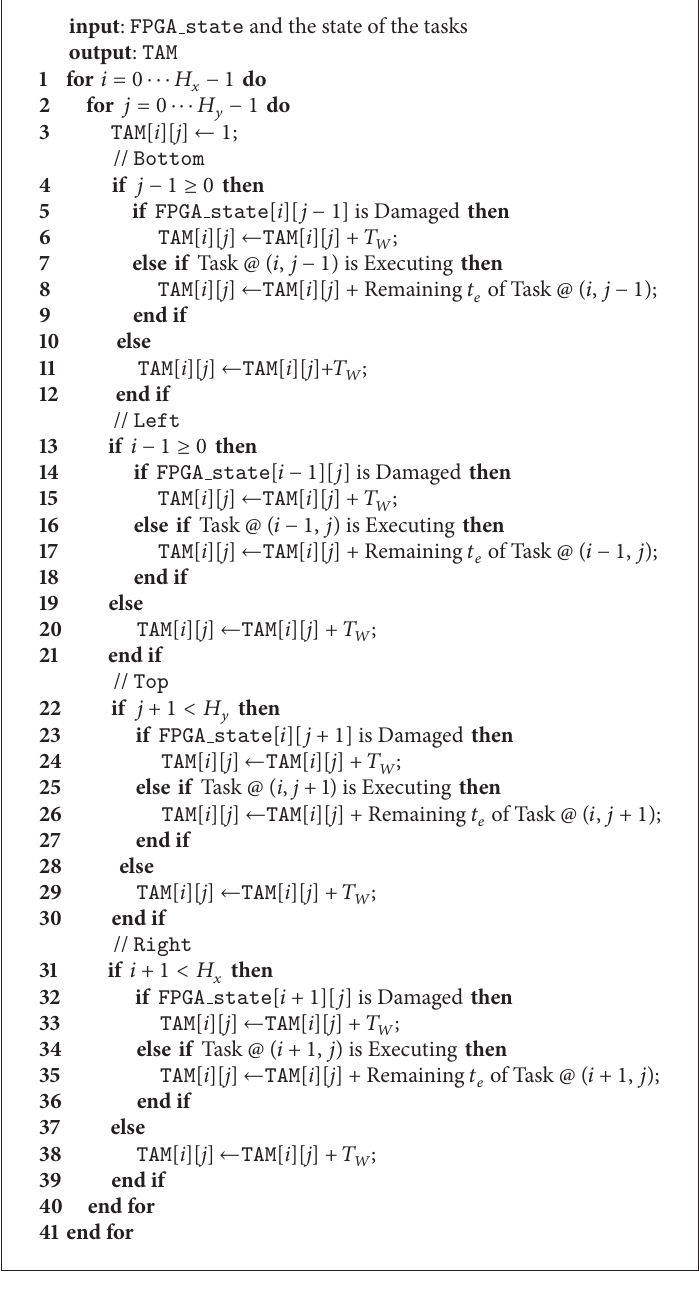
Algorithm 6: EVC heuristic: Compute TAM()